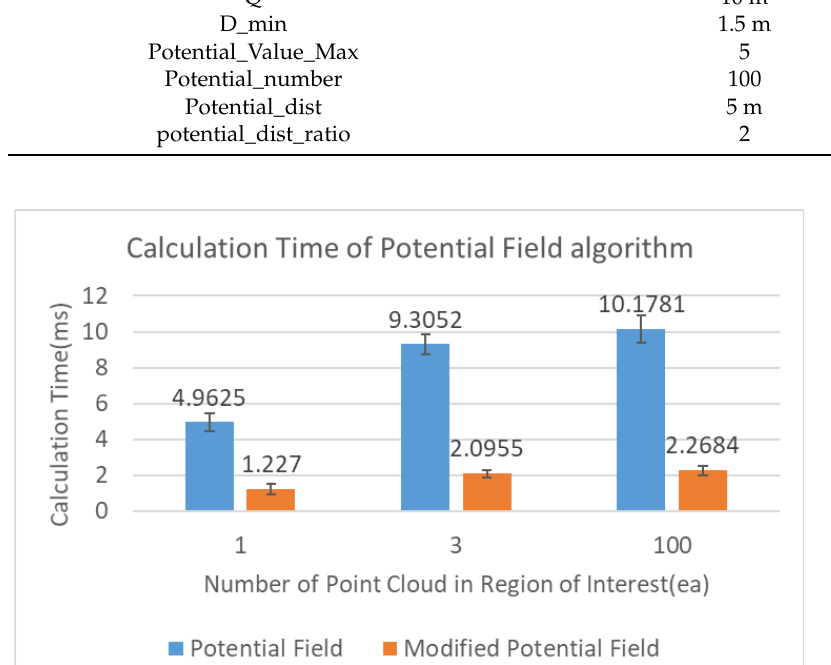
Figure 9. Calculation time of potential field.